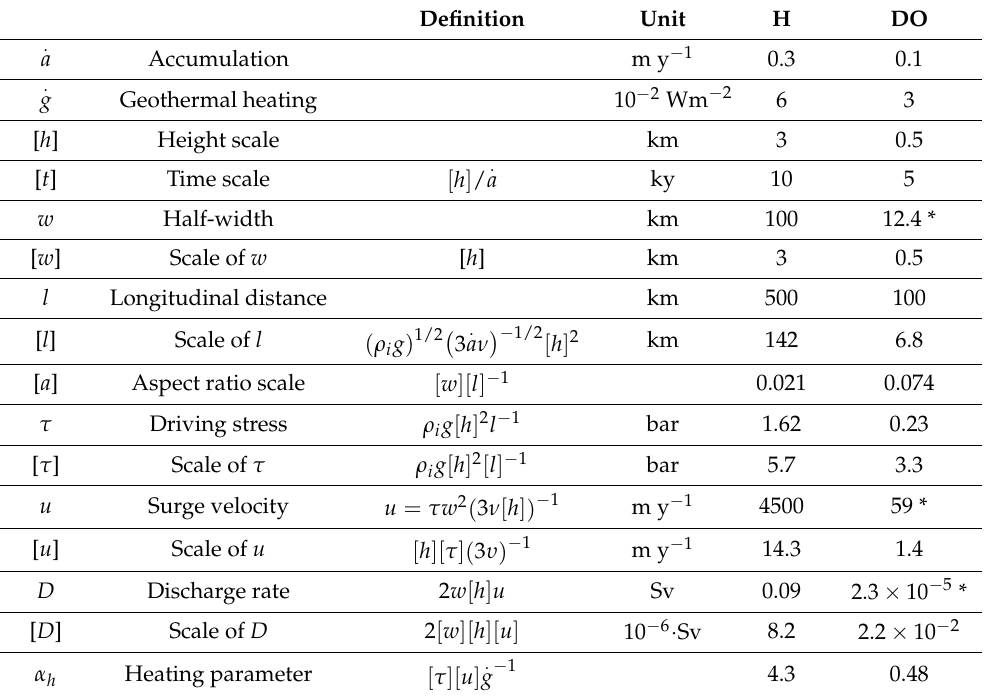
Table 1. Differing ice-discharge parameters for H/DO (starred are from limit-cycle solution). Other (common) values are listed in Appendix